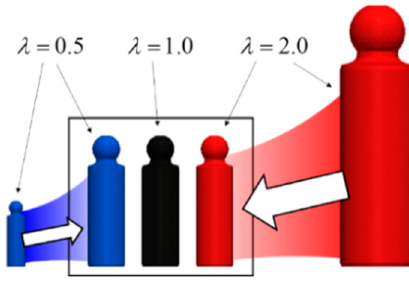
Figure 16. Demonstration of solid body temperature comparison for different sizes.